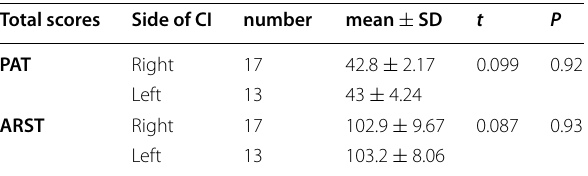
Table 5 Comparison between right- and left-sided cochlear implantees in terms of their PAT and ARST total